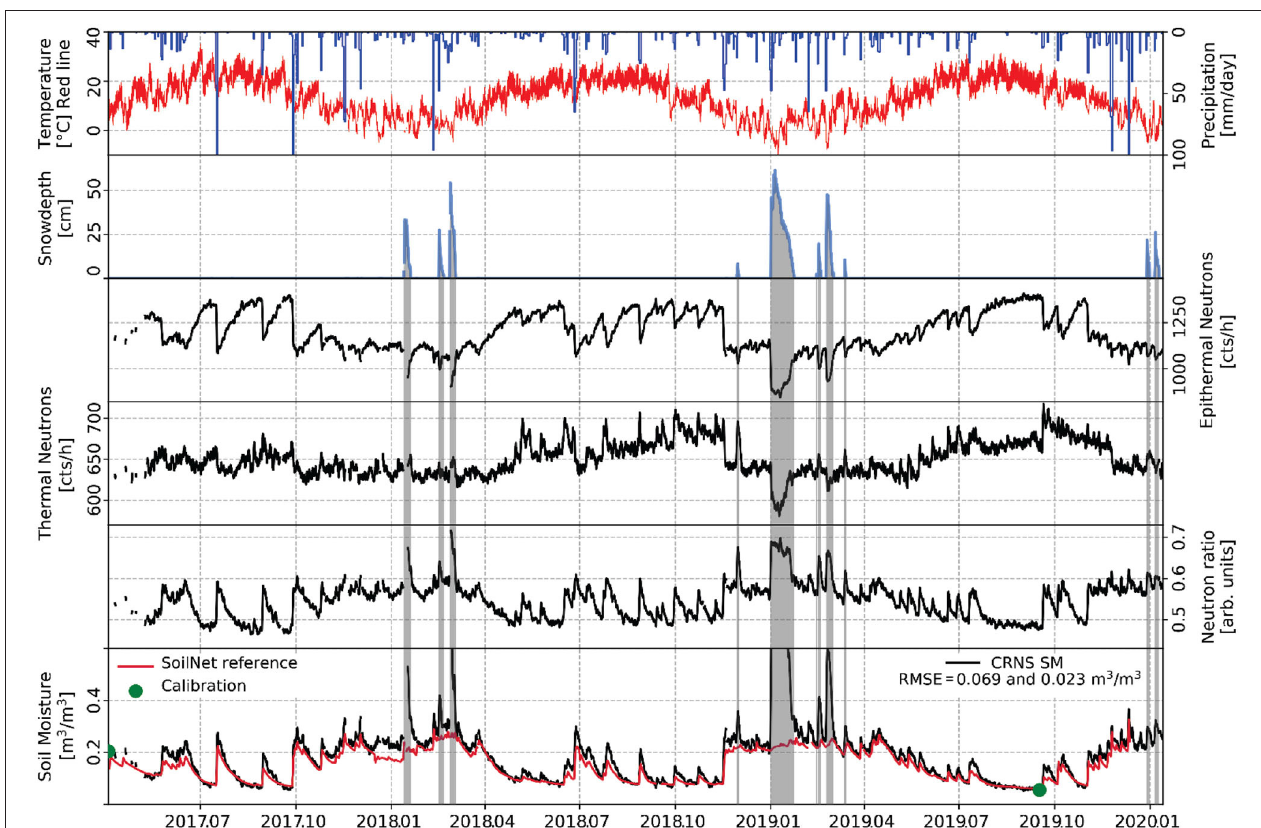
FIGURE 3 | Precipitation, air temperature, snow depth, epithermal neutron and thermal neutron intensity, neutron ratio, vertically and horizontally weighted average in-situ soil moisture (SoilNet), and calibrated CRNP soil moisture from April 3, 2017 to January 13, 2020. The vertically and horizontally weighted average soil moisture from the two calibration campaigns are shown with green dots. The RMSE between soil moisture obtained from CRNP and SoilNet for the whole period and excluding snow events are also